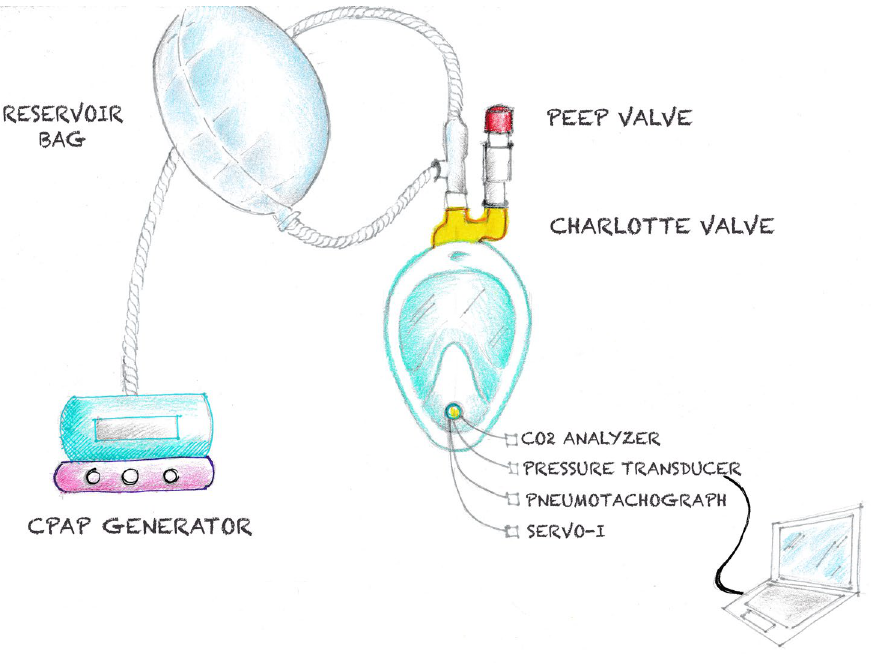
Figure 3. Experimental setup. CPAP continuous positive airway pressure, PEEP positive end expiration